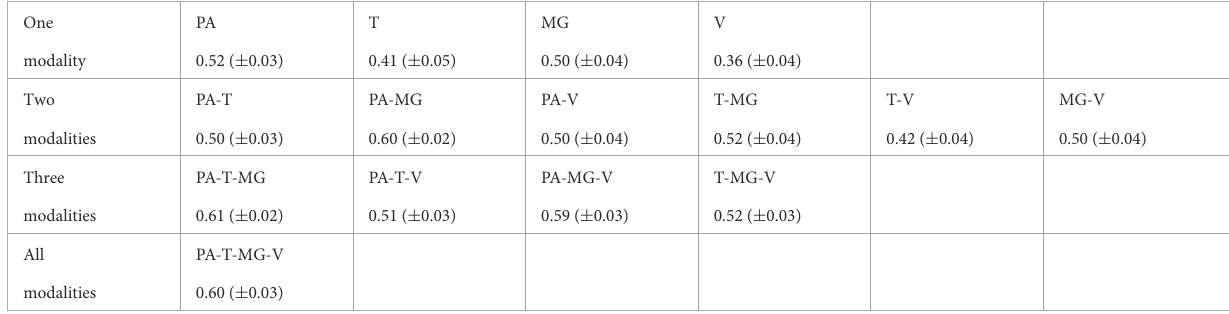
TABLE 6 Performance of unimodal and multimodal feature sets when classifying engagement level on a 3-level